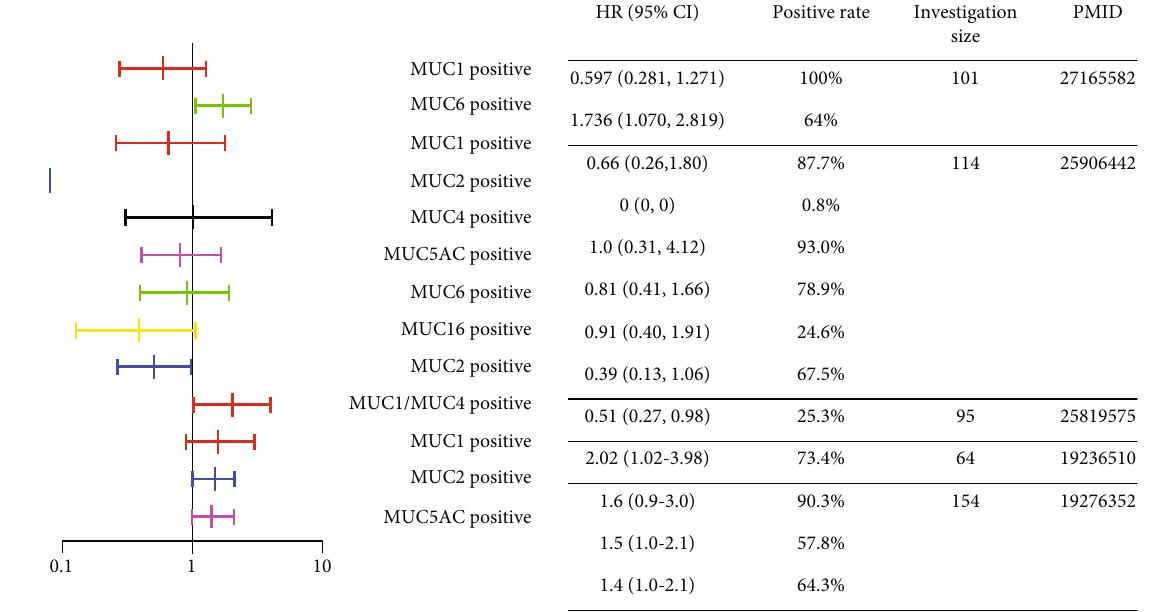
Figure 4: Previous studies on mucins ’ prognostic values in PDAC. Five investigations with reported HR values were included in this forest plot. The X -axis stands for HR. Abbreviations: HR: hazard ratio; CI: con fi dence